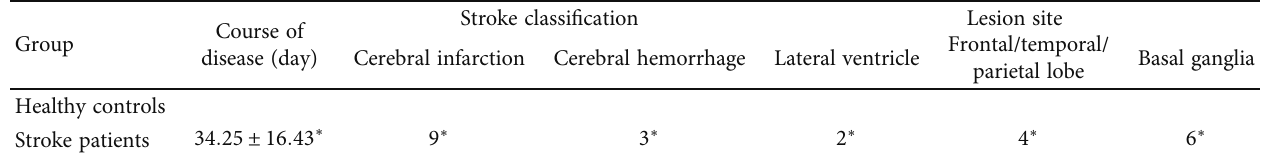
Figure 2: Focal area overlap map in stroke patients. Table 1: Demographic and clinical characteristics of stroke patients and